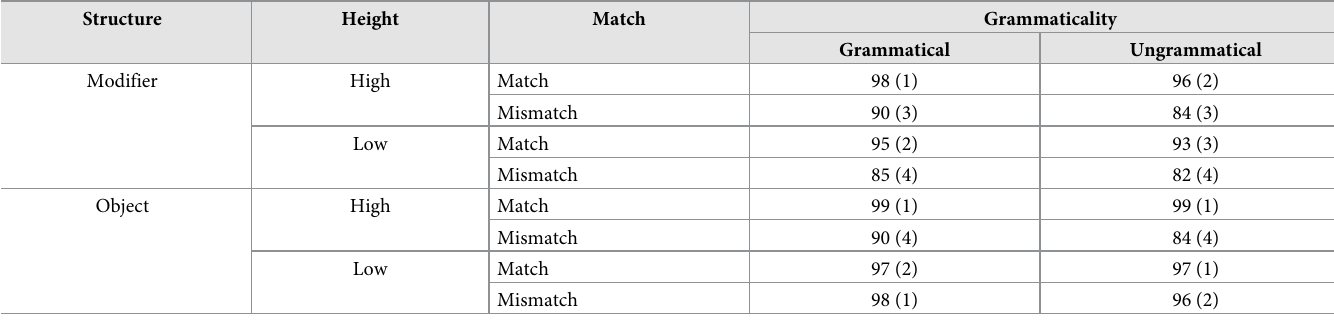
Standard error of the mean is reported in